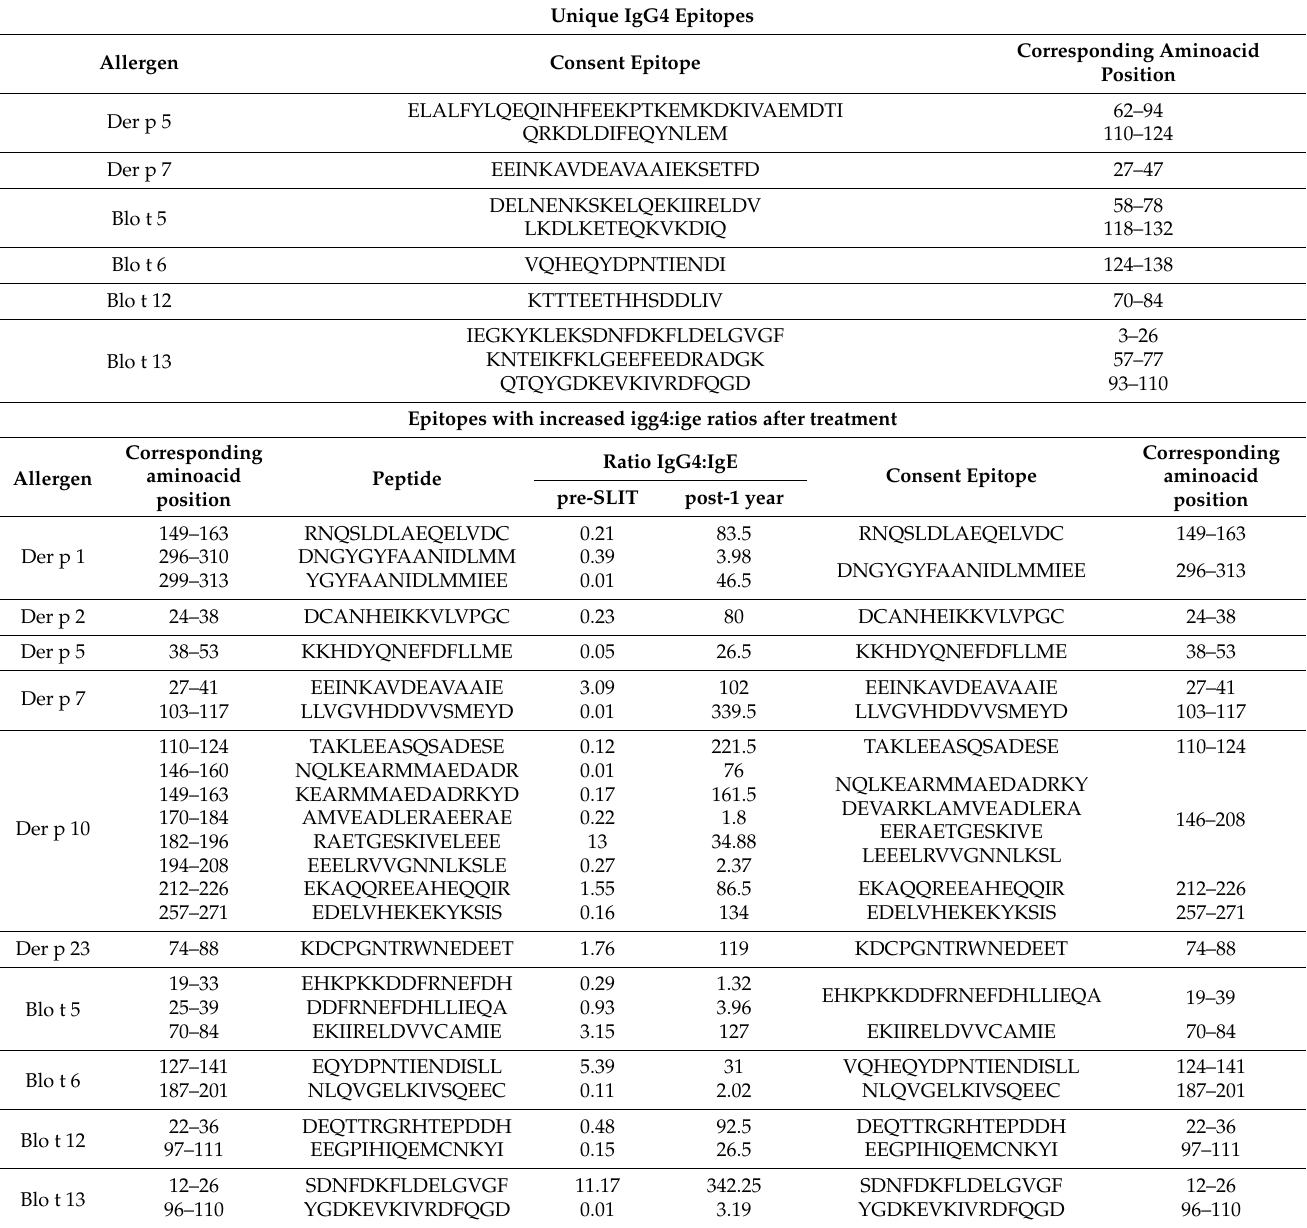
Table 2. Potential targets for vaccine development. Selected peptides that are IgG4 unique or elicited increased IgG4:IgE ratios after one year of